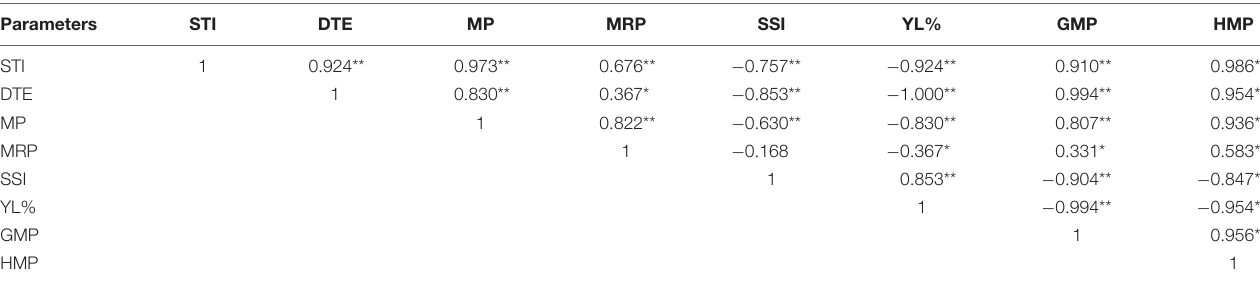
TABLE 5 | Pearson’s correlation matrix among yield indices under drought stress.